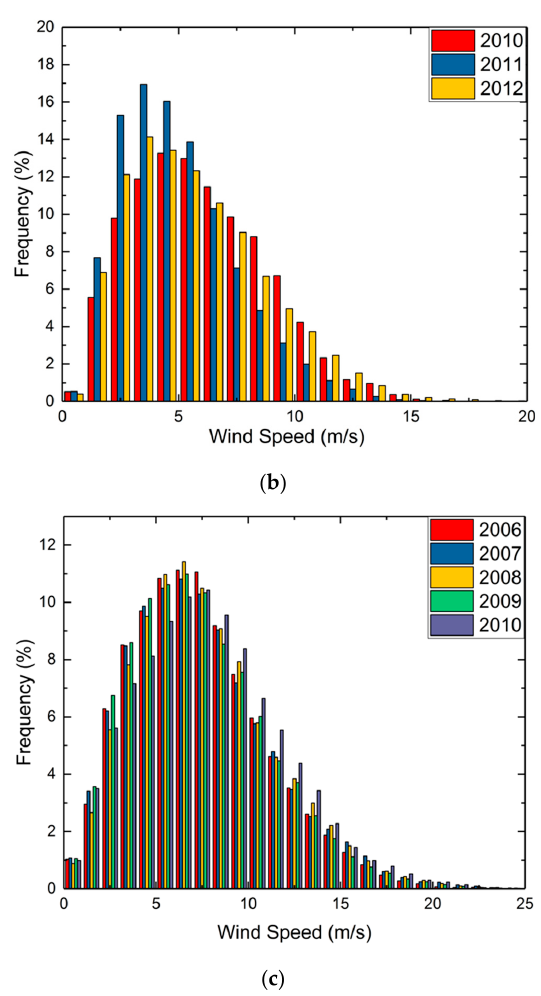
Figure 7. Weibull distribution of wind speed data at 10 min intervals at ( a ) Site A; ( b ) Site B; ( c ) Site C. Table 3. Locations and mean wind speed